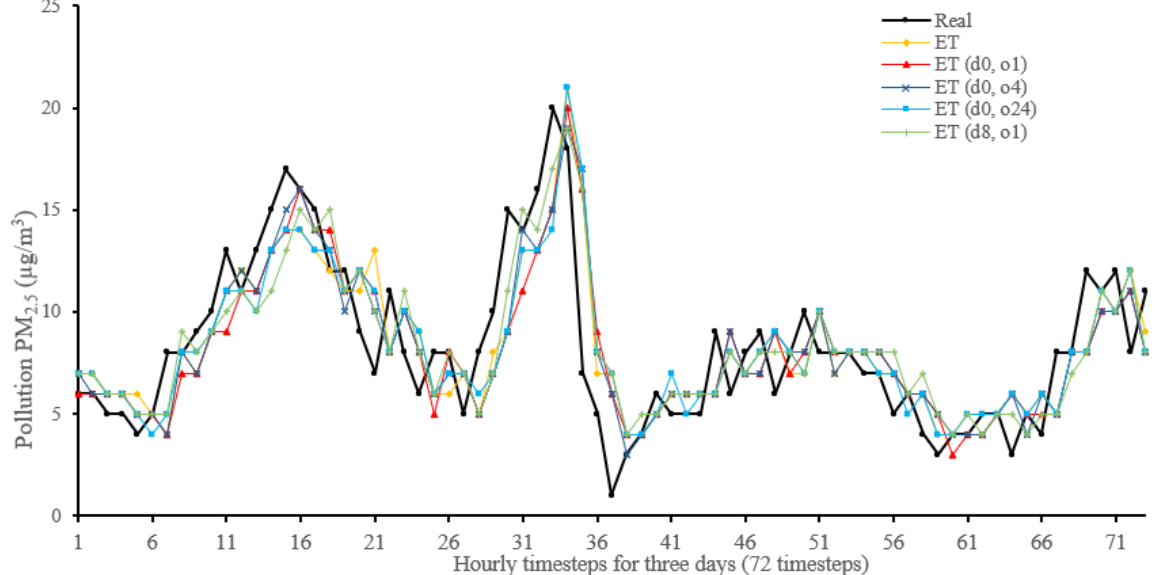
Figure 19. Real vs. Extra Trees and its NARX variants in part of the seventh iteration results for the Manchester dataset.